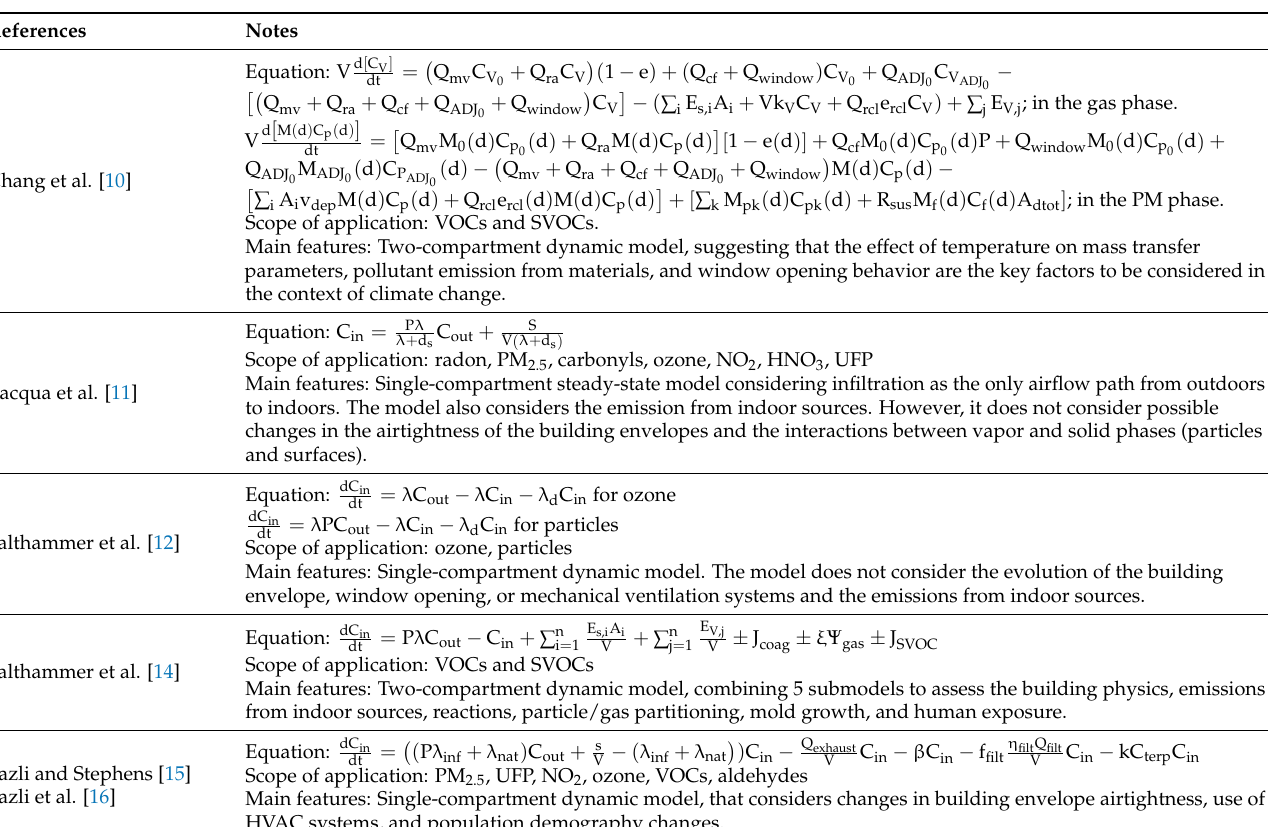
Table 1. Models developed for the assessment of the influence of climate change on indoor air quality. (Note: The definitions of the variables are provided in the